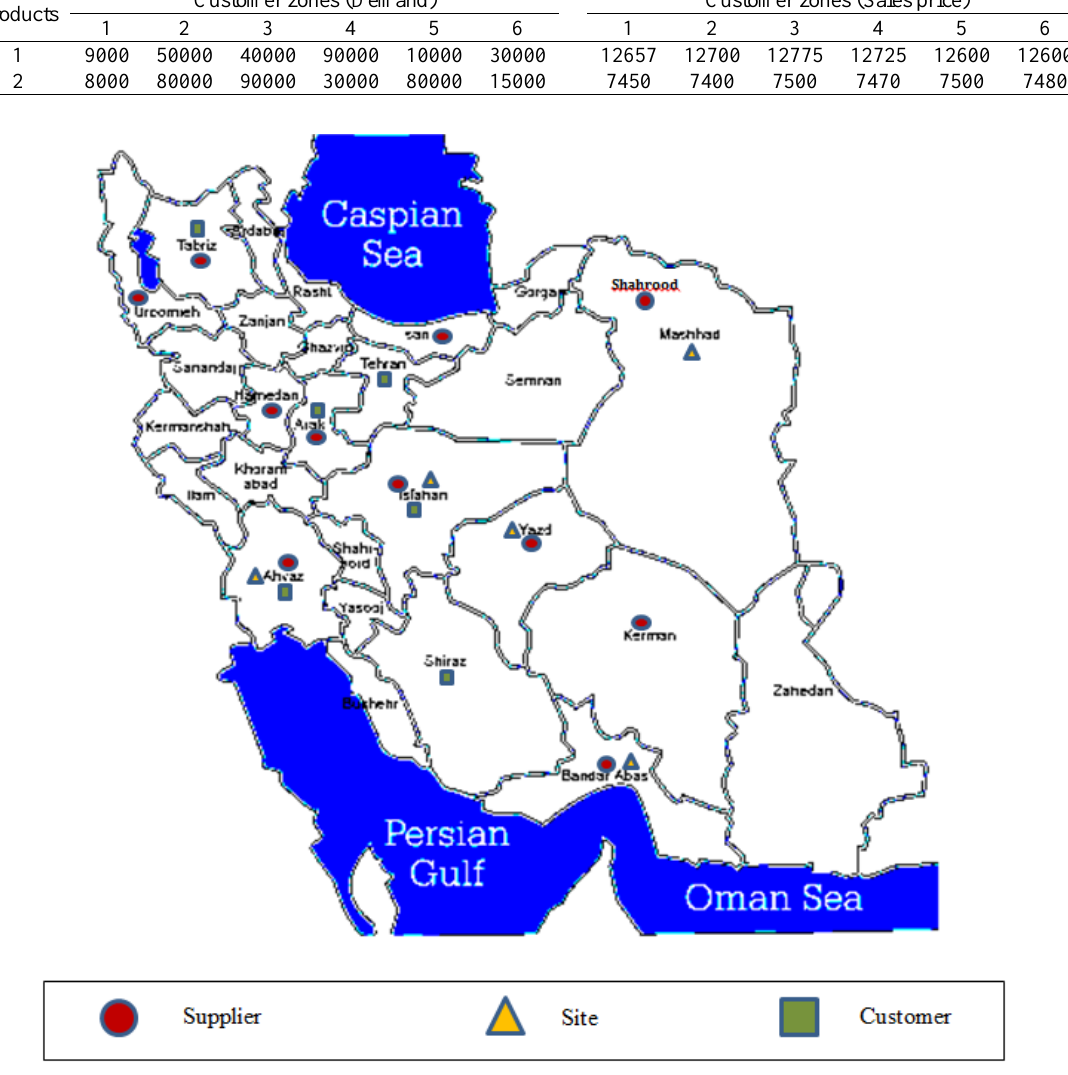
Fig 2. Location of suppliers, plants and